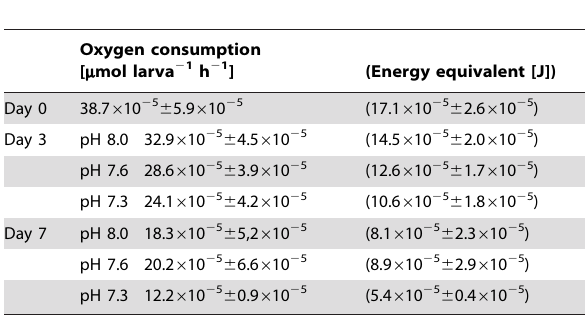
Table 3. Oxygen consumption and converted energy equivalent of planula larvae of Acropora digitifera .